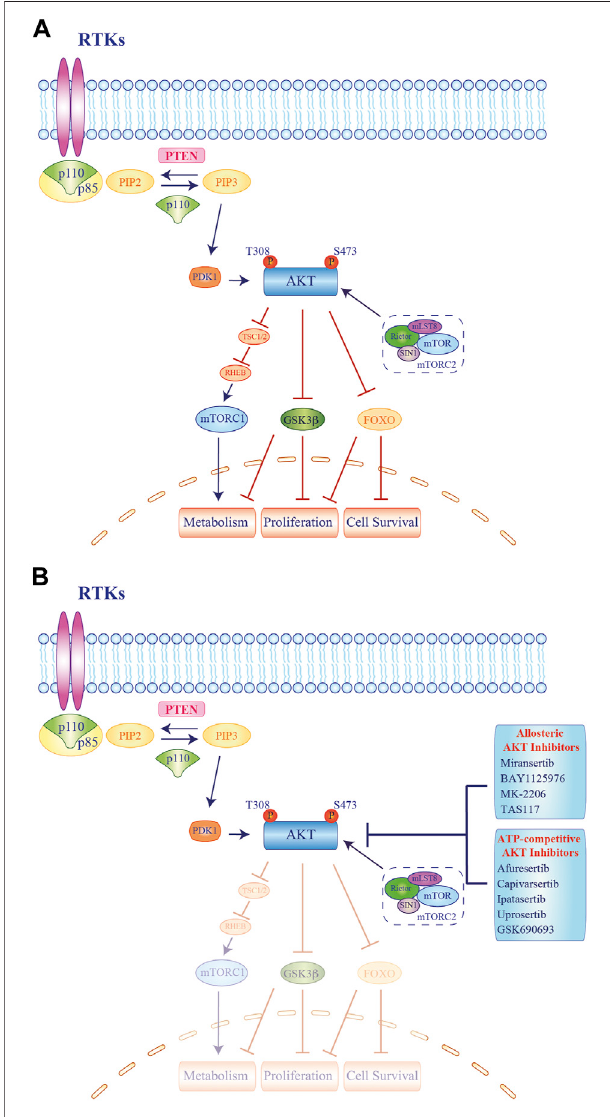
FIGURE 2 | Molecular mechanisms of AKT activation and signaling cascade and schematic representation of current experimental drug combinations employing AKT inhibitors. (A) . Stimulation of growth factor receptor tyrosine kinases (RTKs) leads to activation of class IA phosphatidyl-inositol-3 kinase (PI3Ks). Activated class IA PI3Ks catalyze the conversion of phosphatidyl-inositol-4,5-bisphosphate (PIP2) to the second messenger phosphatidyl-inositol 3,4,5-trisphosphate (PIP3), ina reaction that can be reversed by the PIP3 phosphatase and tensin homolog deleted on chromosome 10 (PTEN). AKT and phosphoinositide-dependent kinase (PDK) 1bindPIP3attheplasmamembrane.AKTactivatedbyphosphorylationofthe T308 residue inhibits the TSC1/2 complex, resulting in RHEB-GTP accumulation, which in turn activates mTORC1. Maximal AKT activation requires phosphorylation by mTORC2. Moreover, AKT inhibits effector proteins via phosphorylation, including glycogen synthase kinase-3 (GSK3) β andforkheadfamilyoftranscriptionfactors(FOXO).Thesignalingresultsinthe regulationofcellproliferation,survival,andmetabolism.Bluearrowsrepresent signaling activation while red bars indicate inhibitory signals. (B) . Activation of AKT can be inhibited by two different direct classes (Allosteric or ATP- competitive)ofAKT inhibitors.Bluearrowsrepresentsignalingactivationwhile blue bars depict inhibition of target signals. RTK (cid:1) receptor tyrosine kinase.